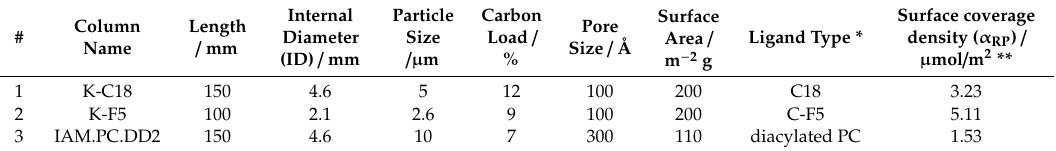
Table 5. Physicochemical parameters of the evaluated chromatographic